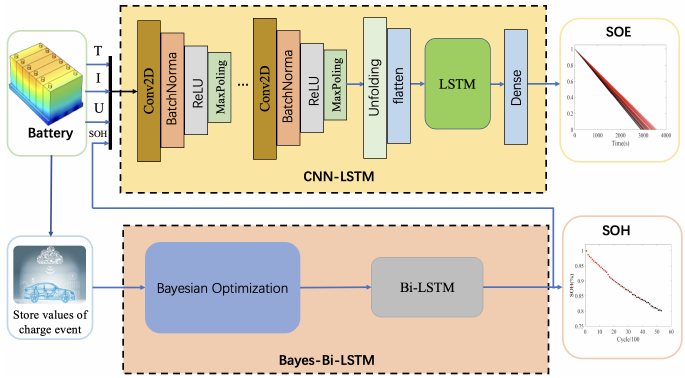
Figure 10. The schematic of joint estimation approach.